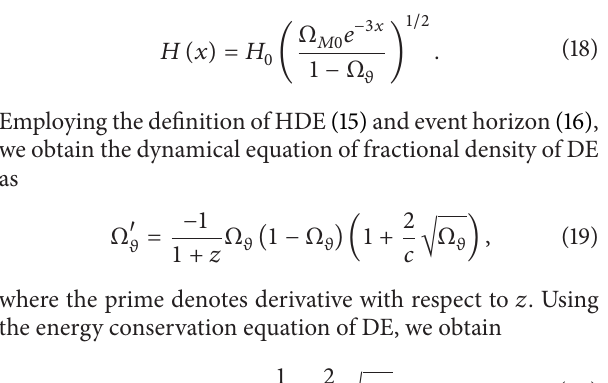
Figure 3: Evolution trajectories of 𝑇 with Ω 𝑚0 = 0.315 , 𝐻 0 = 67.3 , and −1 ⩽ 𝑧 ⩽ 1